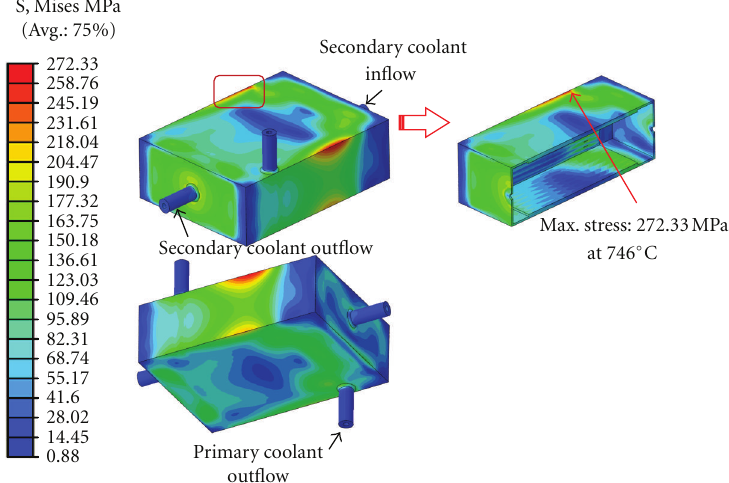
Figure 11: Overall stress contours of a 3kW class PHE prototype from an elastic analysis using the parent material properties